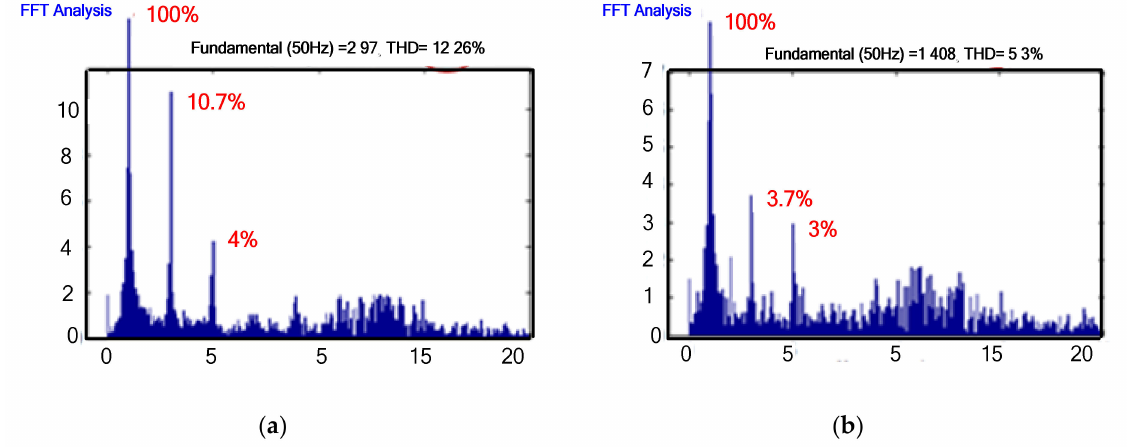
Figure 15. FFT analysis of experimental grid current during 70% LVRT for ( a ) non-swap control and ( b ) swap